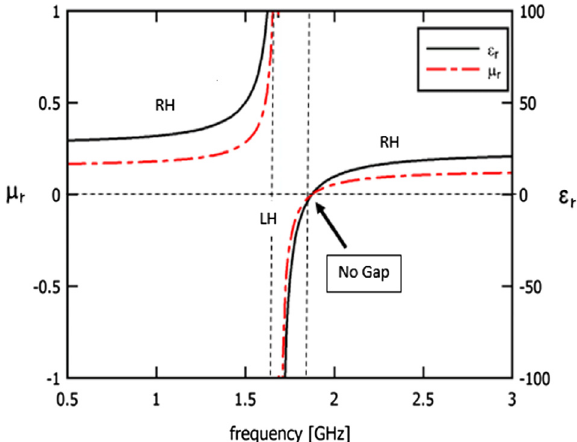
Figure 2. DL TL metamaterial constitutive parameters for a specific set of LC